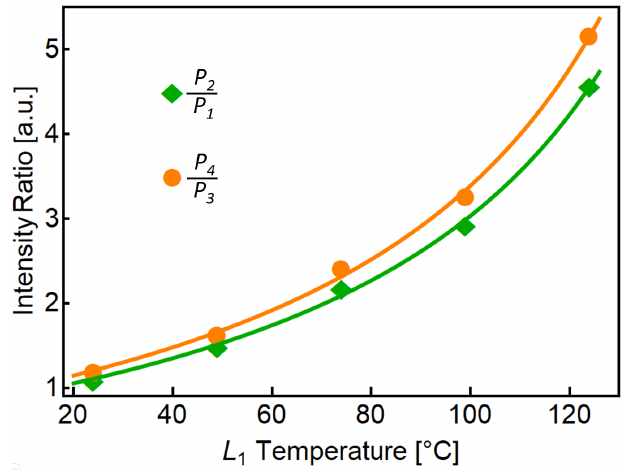
Figure 7. Intensity ratio as a function of applied temperature with solid green and solid orange curves corresponding to the ratios of peaks P 2 / P 1 and P 4 / P 3 , respectively.